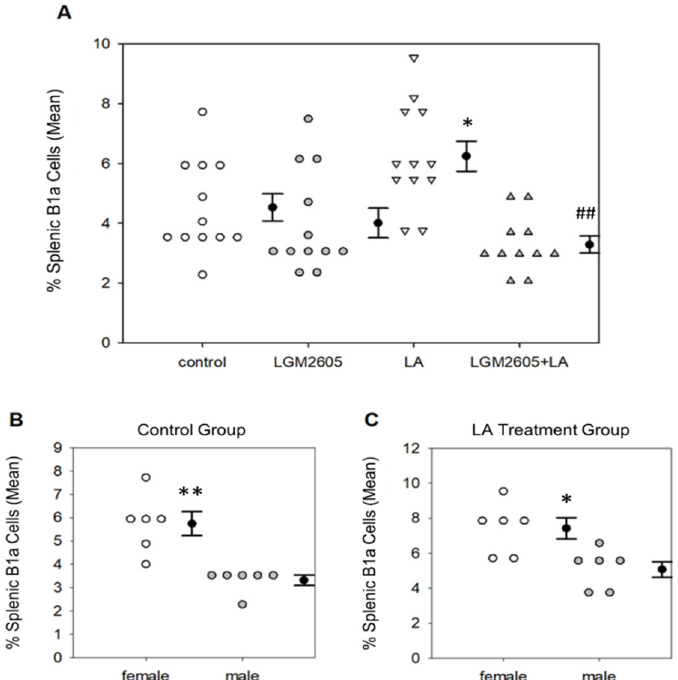
Figure 5. Detection of splenic B1a B cells by flow cytometry. ( A ) LA treatment significantly increased the percentage of splenic B1a B cells compared to saline control, * p = 0.043; LGM2605 + LA treatment reduced the percentage of splenic B1a B cells back to control levels, ## p < 0.01 as compared to LA treatment. Following two-way ANOVA, data were analyzed via Tukey post-hoc test. Female mice had a significantly higher percentage of splenic B1a B cells compared to males in both the control group ( B ), ** p < 0.01 by one-way ANOVA, and the LA only group ( C ), * p = 0.015 by one-way ANOVA.